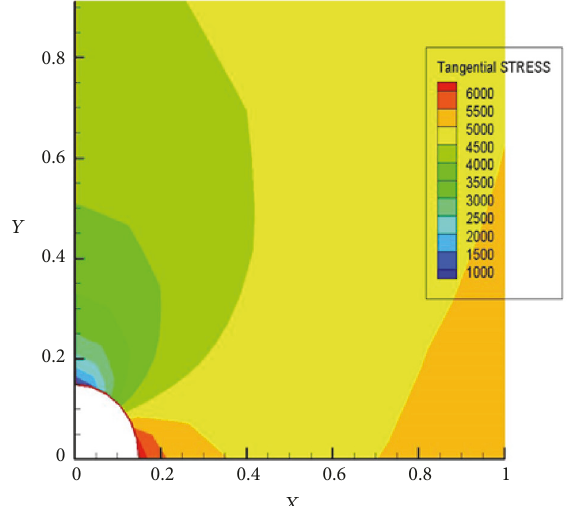
Figure 9: 𝑋 -component of tangential stresses contour map after 1hr of fluid production (for near-wellbore region) with 𝜎 𝐻 = 5800 psi and 𝜎 ℎ = 5500 psi, 𝑃 𝑟 = 5500 psi, 𝑃 𝑤 = 1000 psi, 𝑘 𝑥 = 0.01 md, and 𝑘 𝑦 = 0.01